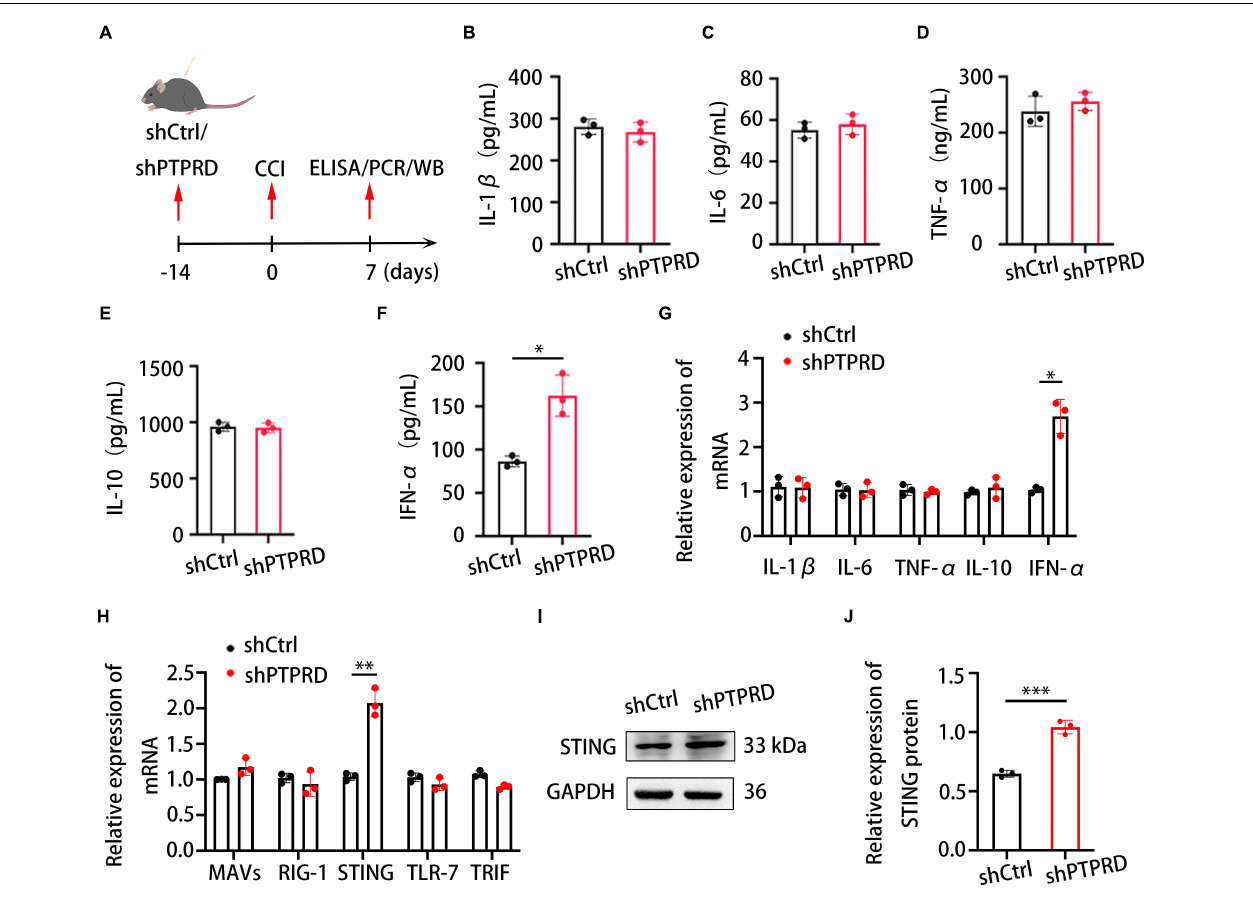
FIGURE 4 | Protein tyrosine phosphatase receptor type D knockdown increases IFN- α and STING levels in the DRG after CCI. (A) Schedule of lentivirus administration, surgery, ELISA, qRT-PCR, and Western blotting. (B–F) ELISA assessing IL-1 β , IL-6, TNF- α , IL-10, and IFN- α levels in the DRG after shCtrl or shPTPRD virus injection. CCI + shPTPRD vs. CCI + shCtrl, N = 3. For IFN- α , ∗ p < 0.05. (G) qRT-PCR analysis of the relative expression of IL-1 β , IL-6, TNF- α , IL-10, and IFN- α in the DRG after shCtrl or shPTPRD virus injection. CCI + shPTPRD vs. CCI + shCtrl, N = 3. For IFN- α , ∗ p < 0.05. (H) qRT-PCR analysis of the relative expression of MAVS, RIG-1, STING, TLR-7, and TRIF in the DRG after shCtrl or shPTPRD administration. CCI + shPTPRD vs. CCI + shCtrl, N = 3. For STING, ∗∗ p < 0.01. (I) Western blot evaluation of the DRG levels of STING after shCtrl or shPTPRD treatment. Experiment was repeated three times. (J) Quantitative analysis of data in (H) . CCI + shPTPRD vs. CCI + shCtrl, N = 3, ∗∗∗ p < 0.001. Statistical comparisons were performed by unpaired Student’s t -test (B–H,J)